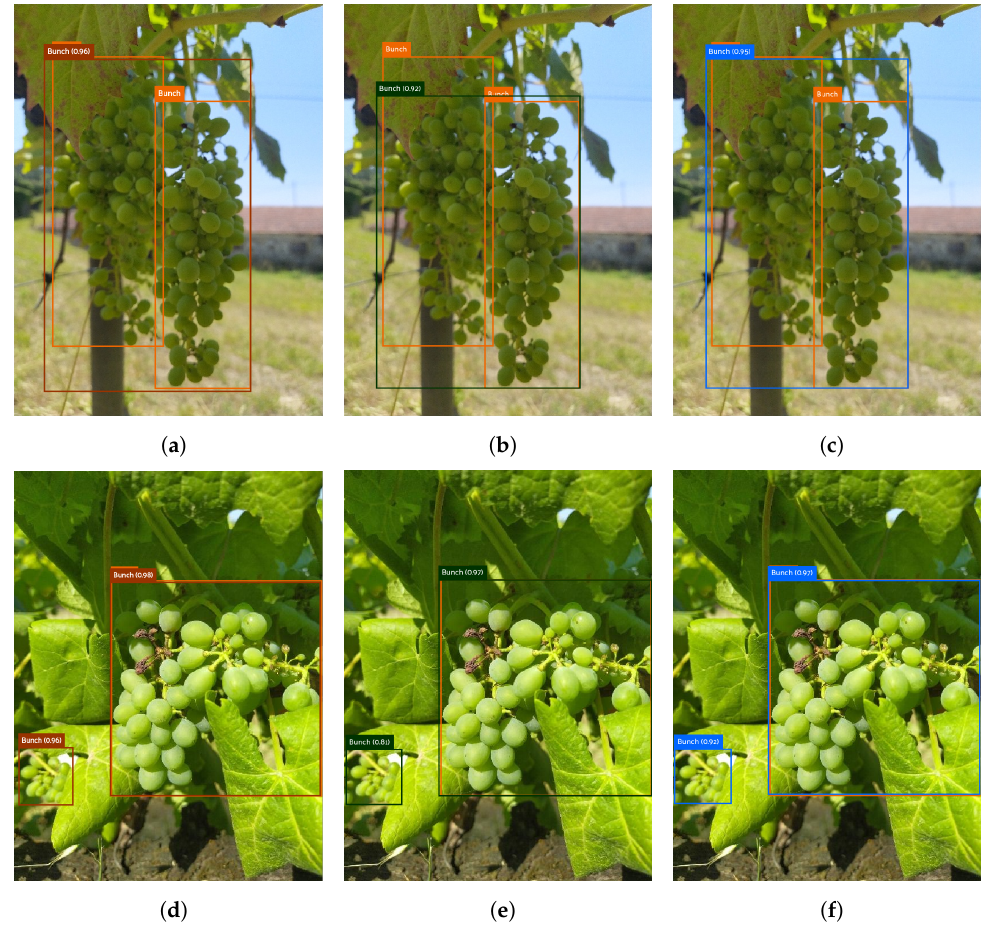
Figure 5. FPs in samples from the test set. Orange bounding boxes present ground truth. Red bound- ing boxes present the predictions from YOLOv5. Green bounding boxes present the predictions from YOLOv7. Blue bounding boxes present the predictions from YOLOR. ( a ) Example 1—YOLOv5. ( b ) Ex- ample 1—YOLOv7. ( c ) Example 1—YOLOR. ( d ) Example 2—YOLOv5. ( e ) Example